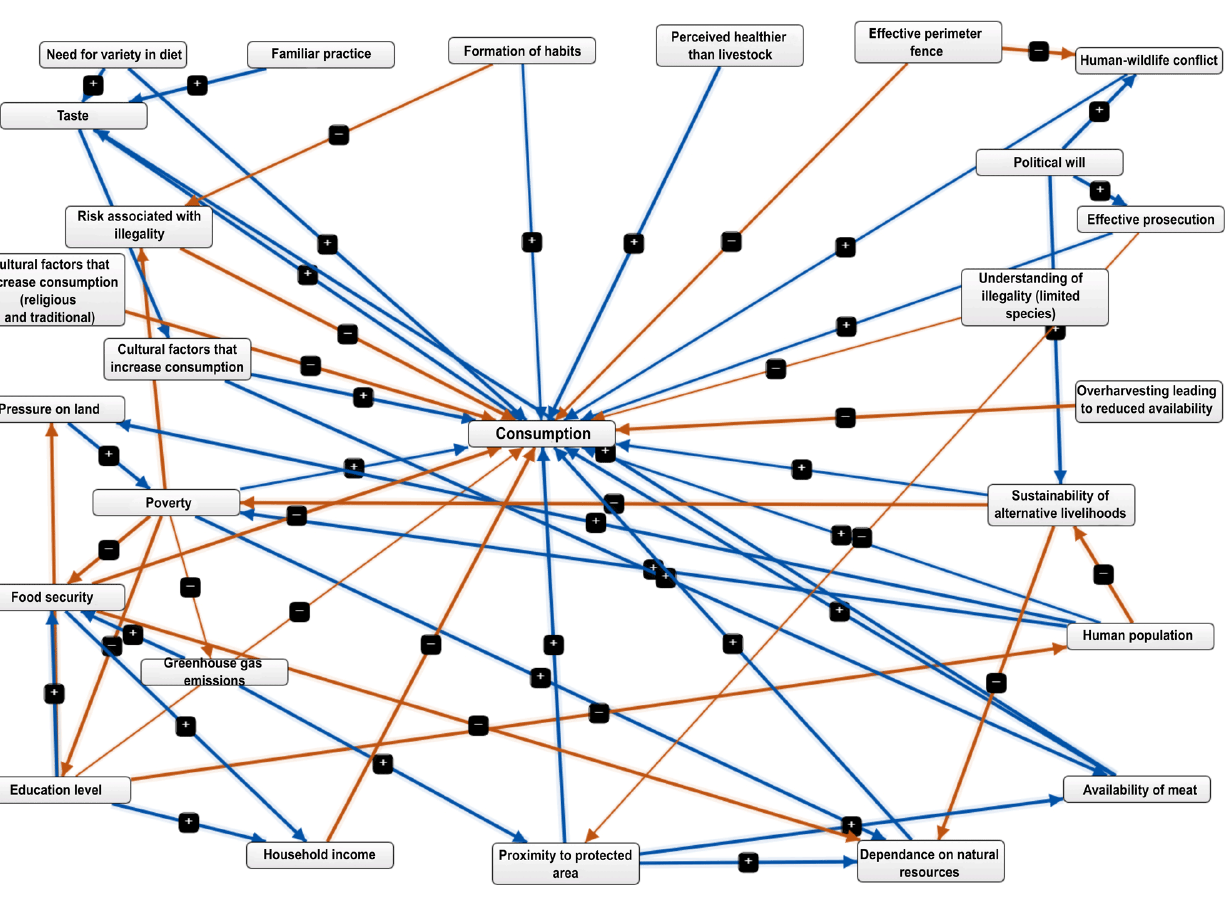
Fig. 2 . Finalized fuzzy cognitive map for bushmeat consumption in Malawi, where blocks represent important components and arrows represent relationships between components. The color of the arrow indicates whether the relationship is positive (blue) or negative (orange). The width of the arrow indicates the strength of the relationship (where strong relationships are wider than weak relationships). Generated using MentalModeler